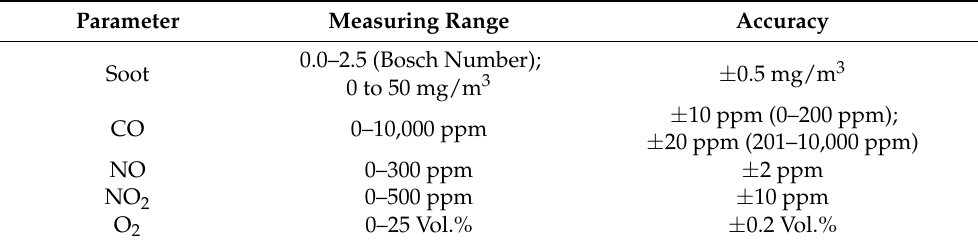
Table 2. Accuracy of the measurements for different parameters.